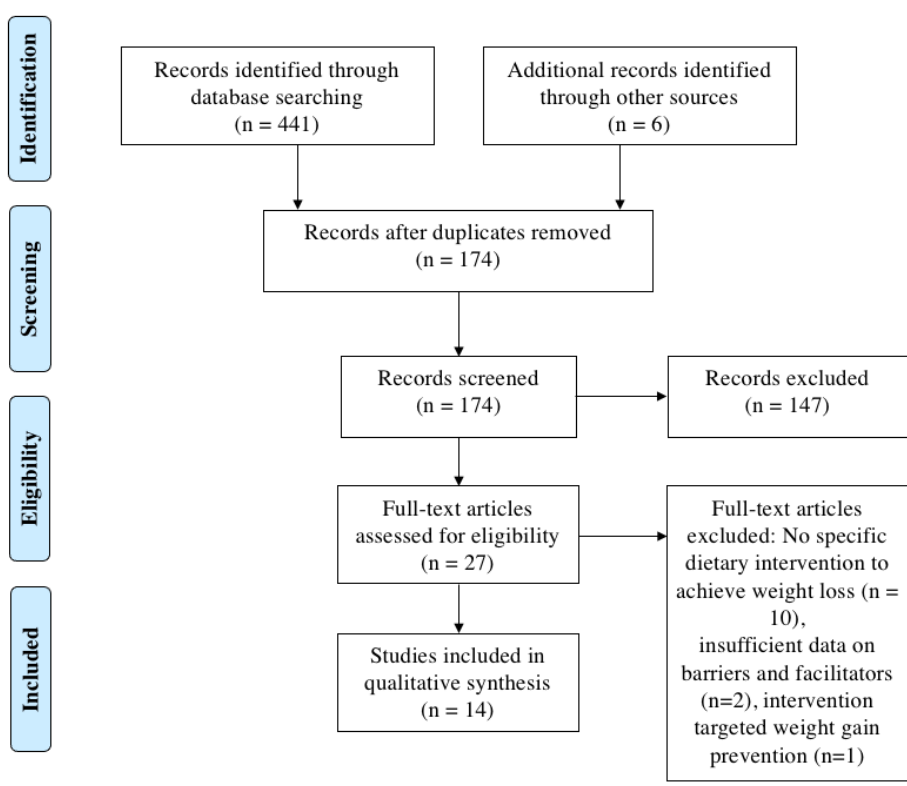
Figure 1. PRISMA diagram outlining the process of selecting studies for inclusion in this review.